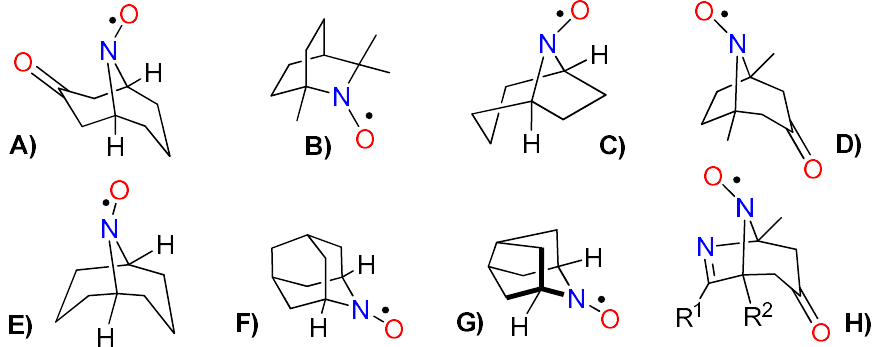
Figure 1. Selected examples of known BNRs: ( A ) Norpseudopelleterine N -oxyl [32]; ( B ) trimethylisoquinuclidine N -oxyl [33]; ( C ) nortropane N -oxyl [34]; ( D ) dimethylnortropinone N -oxyl [35]; ( E ) 9-azabicyclo[3.3.1]nonane N -oxyl (ABNO) [36]; ( F ) 2-azaadamantane N -oxyl (AZADO) [37]; and ( G ) 9-azanoradamantane N -oxyl (nor-AZADO) [38]. ( H ) The BNRs obtained in this work.